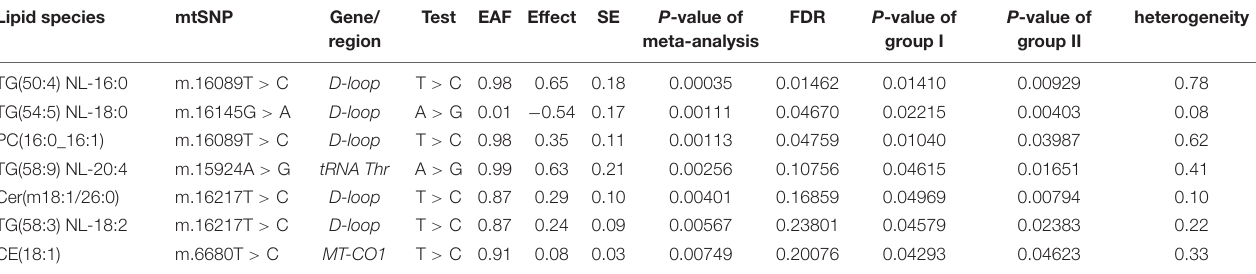
TABLE 2 | Significant associations of mitochondrial genetic variants with lipid species.